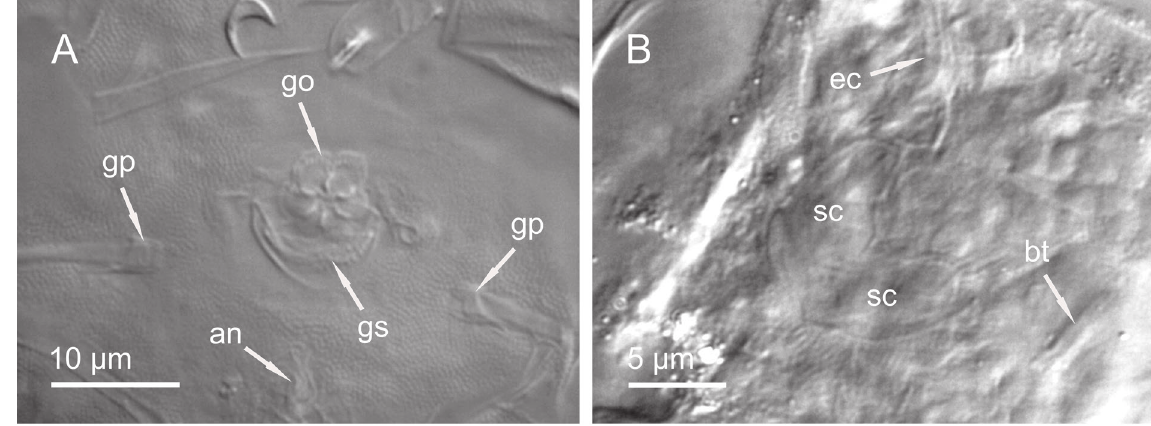
Fig. 18. Higginsarctus alatus (Gomes-Júnior, E. Santos, da Rocha, P.J.P. Santos & Fontoura, 2018) gen. et comb. nov. A . Holotype (C.VII-84). Close up on the caudal region, ventral view showing the gonopore, genital stoup, anus and genital papillae. B . Paratype (C.VII-87). Close up on the secondary clava. Abbreviations: see Material and